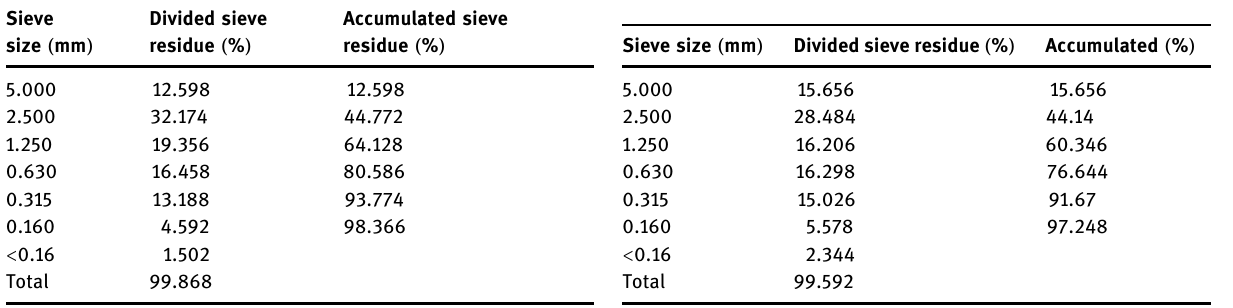
Table 3: Sieve residue percentage of natural sand Sieve size ( mm